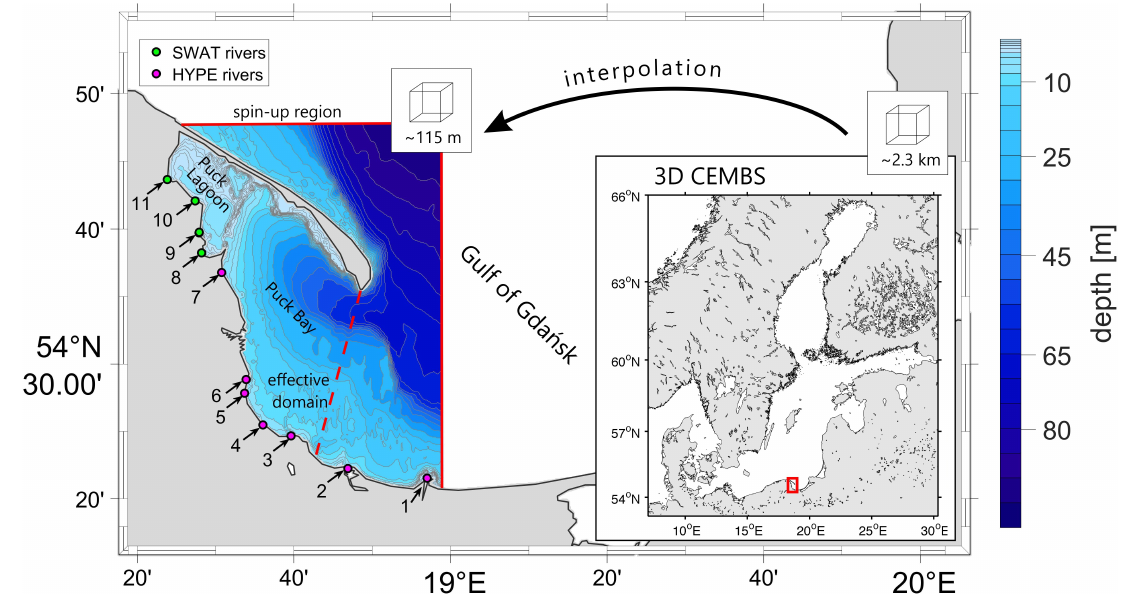
Figure 1. Model of the effective domain with topography and locations of mouths of watercourses included in the domain: Green dots (8–11) represent rivers that are delivered using the Soil & Water Assessment Tool (SWAT) hydrological model. Purple dots (1–7) indicate rivers with flows from the Hydrological Predictions for the Environment (HYPE)